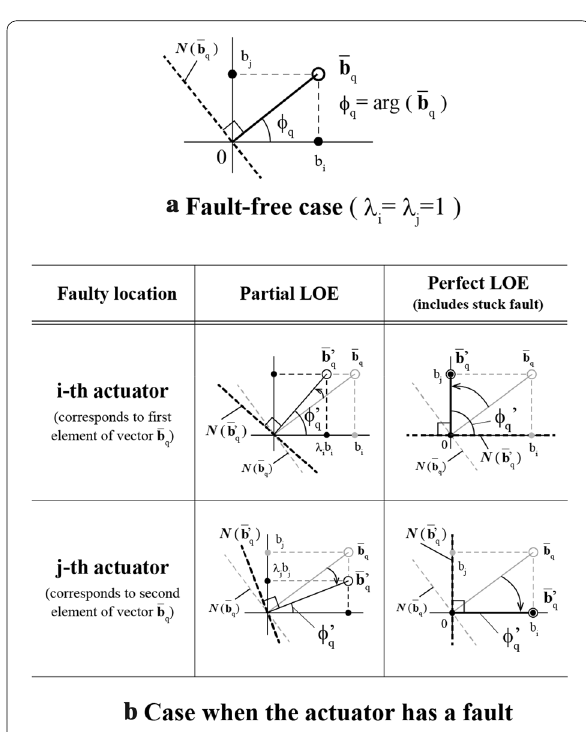
Fig. 7 Changes to vector ¯ b q caused by corresponding fault patterns with argument ¯